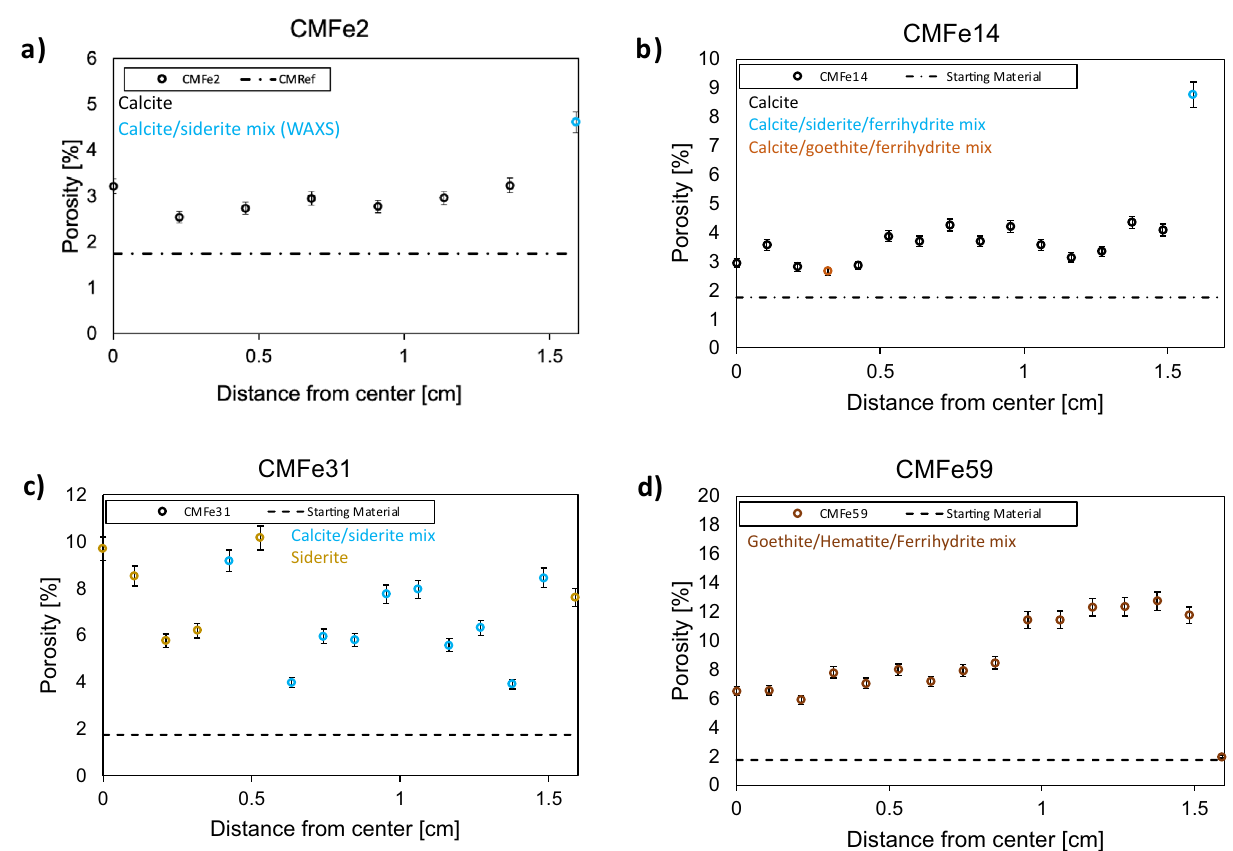
Figure 7. Porosity development in the CM limestone with reaction time as characterized by (U)SAXS. Phase determination as determined by WAXS is given in the color code.